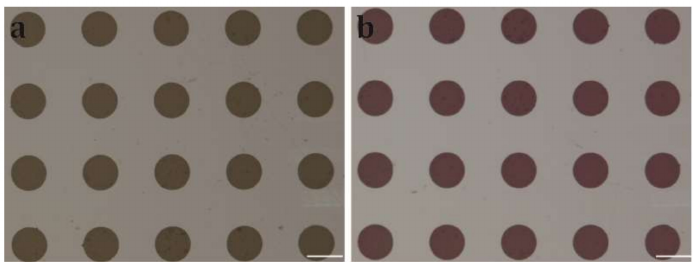
Figure 6. Optical images of the hydrophilic graphene oxide thin film array modified on hydrophobic Cytop surface. ( a ) The graphene oxide thin film array at dry state. ( b ) The graphene oxide thin film array with droplets of rhodamine solution pinned on top of the graphene oxide. Scale bars: 500 µ